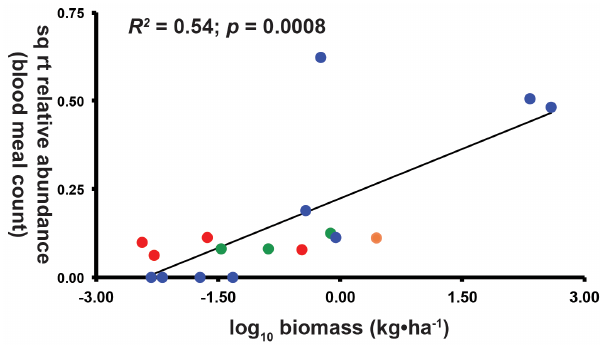
Figure 3. Relative abundance of vertebrate blood meals as a function of estimated host biomass. Red circles represent wild birds, green circles: wild mammals, orange circle: chickens, blue circles: domestic mammals, humans: black circle. Wild animals have both low biomass and blood meal relative abundance while humans and domestic animals have both high biomass and proportion of the observed blood meals. Estimated host biomass is log-transformed, while blood meal relative abundance is square-root transformed, with data representing biomass for taxa across the matrix of agricultural and forest habitats, see Methods S1 for details on methodology.